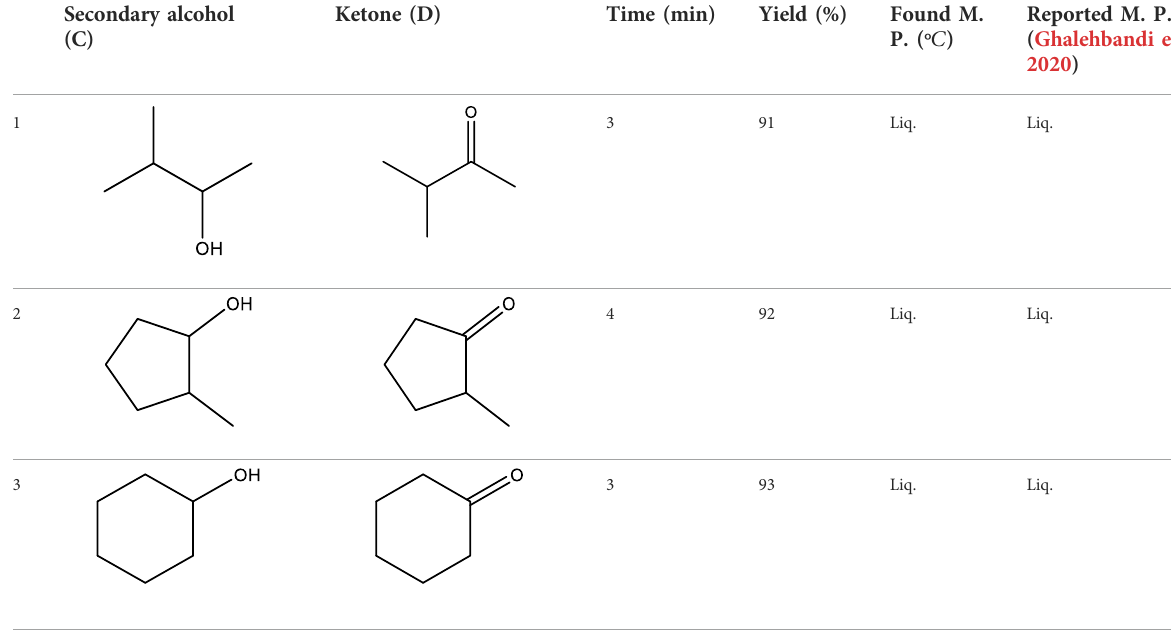
TABLE 3 Green oxidation of secondary alcohol derivatives to ketone derivatives using CCPSF NPs under MW irradiation. Secondary alcohol